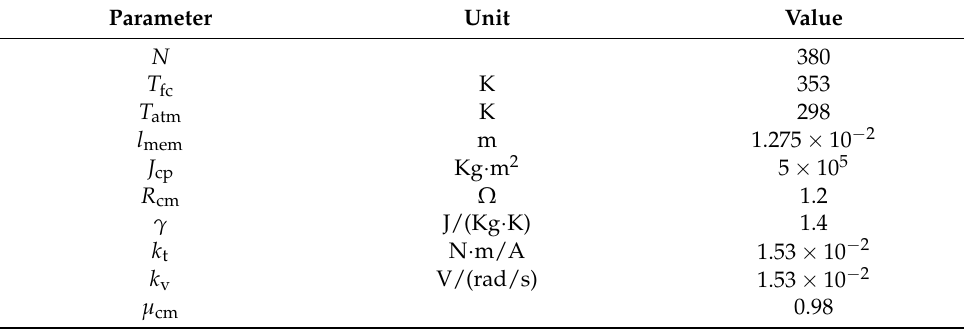
Table A1. System parameter